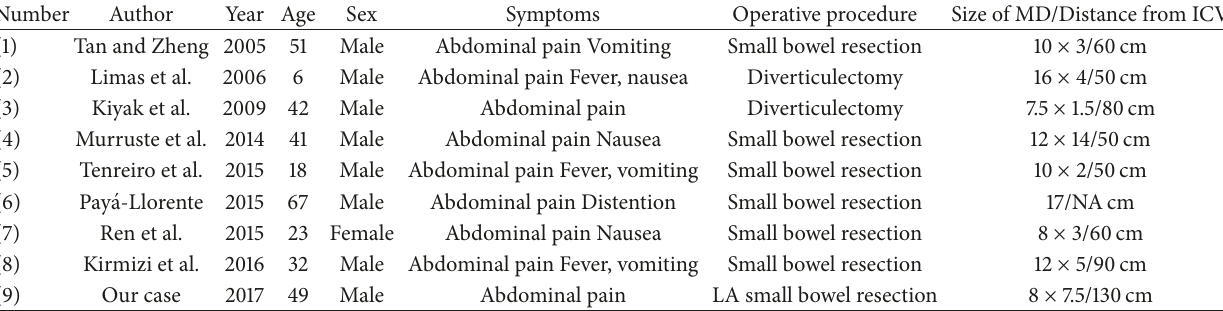
Table 1: Previous reports of Meckel’s diverticulum torsion in English